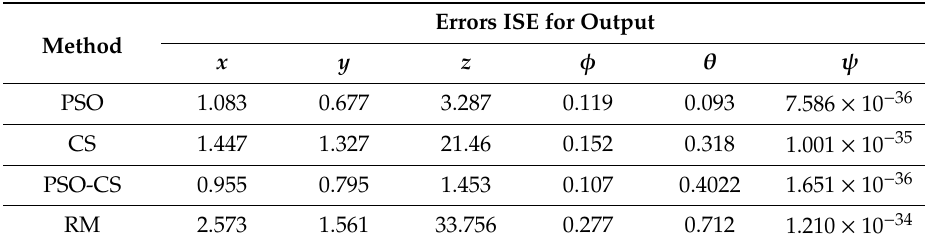
Table 5. Errors (ISE-Integral Square Error) obtained with Particle Swarm Optimization (PSO), Cuckoo Search (CS), Particle Swarm Optimization-Cuckoo Search (PSO-CS), and Reference Model (RM) for the quadrotor (rectangular trajectory).